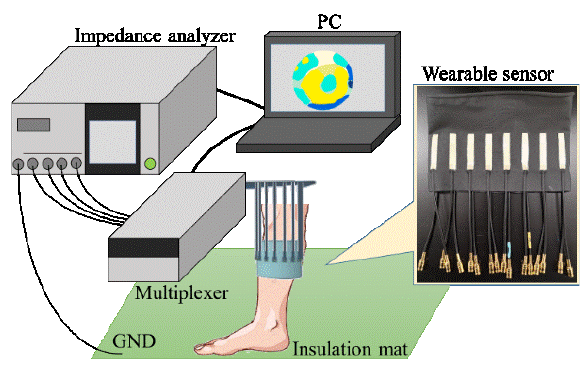
Fig. 2. Experimental setup.